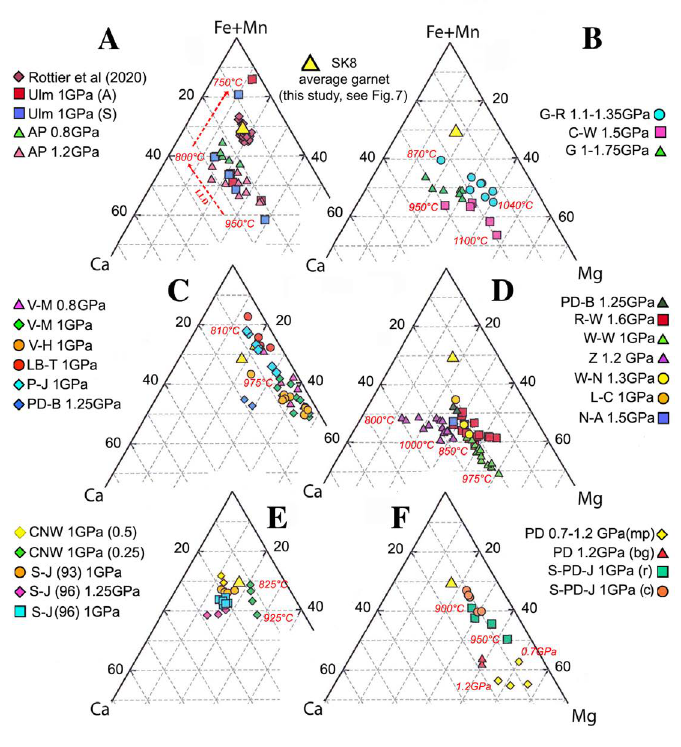
Figure 11: (Fe ` Mn)-Ca-Mg ternary plots showing compositions of various synthetic garnets obtained in HT-HP ex- periments. All Fe as FeO. Pressures and temperatures are those corresponding to occurrence of garnets shown in the diagrams ; the whole set of experimental conditions cited in the following papers may be larger. Composition of average Breziny garnet is reported for comparison in any diagram (yellow triangle). [A] Most recent and detailed crystallisation experiments. AP = Alonso-Perez et al. [2009]: on a synthetic andesite, 0.8–1.2 GPa (green and red triangles respectively), 850 to 1000 °C, 4 to 8 wt% H O; Ulm = Ulmer et al. [2018]: two series of fractional crystallisa- 2 tion experiments starting from a high-Mg andesite (blue squares) and a high-Mg basalt (red squares), 1 GPa, 950 to 750 °C. Dotted line = liquid line of descent. Garnet analyses from Rottier et al. [2019] are reported for